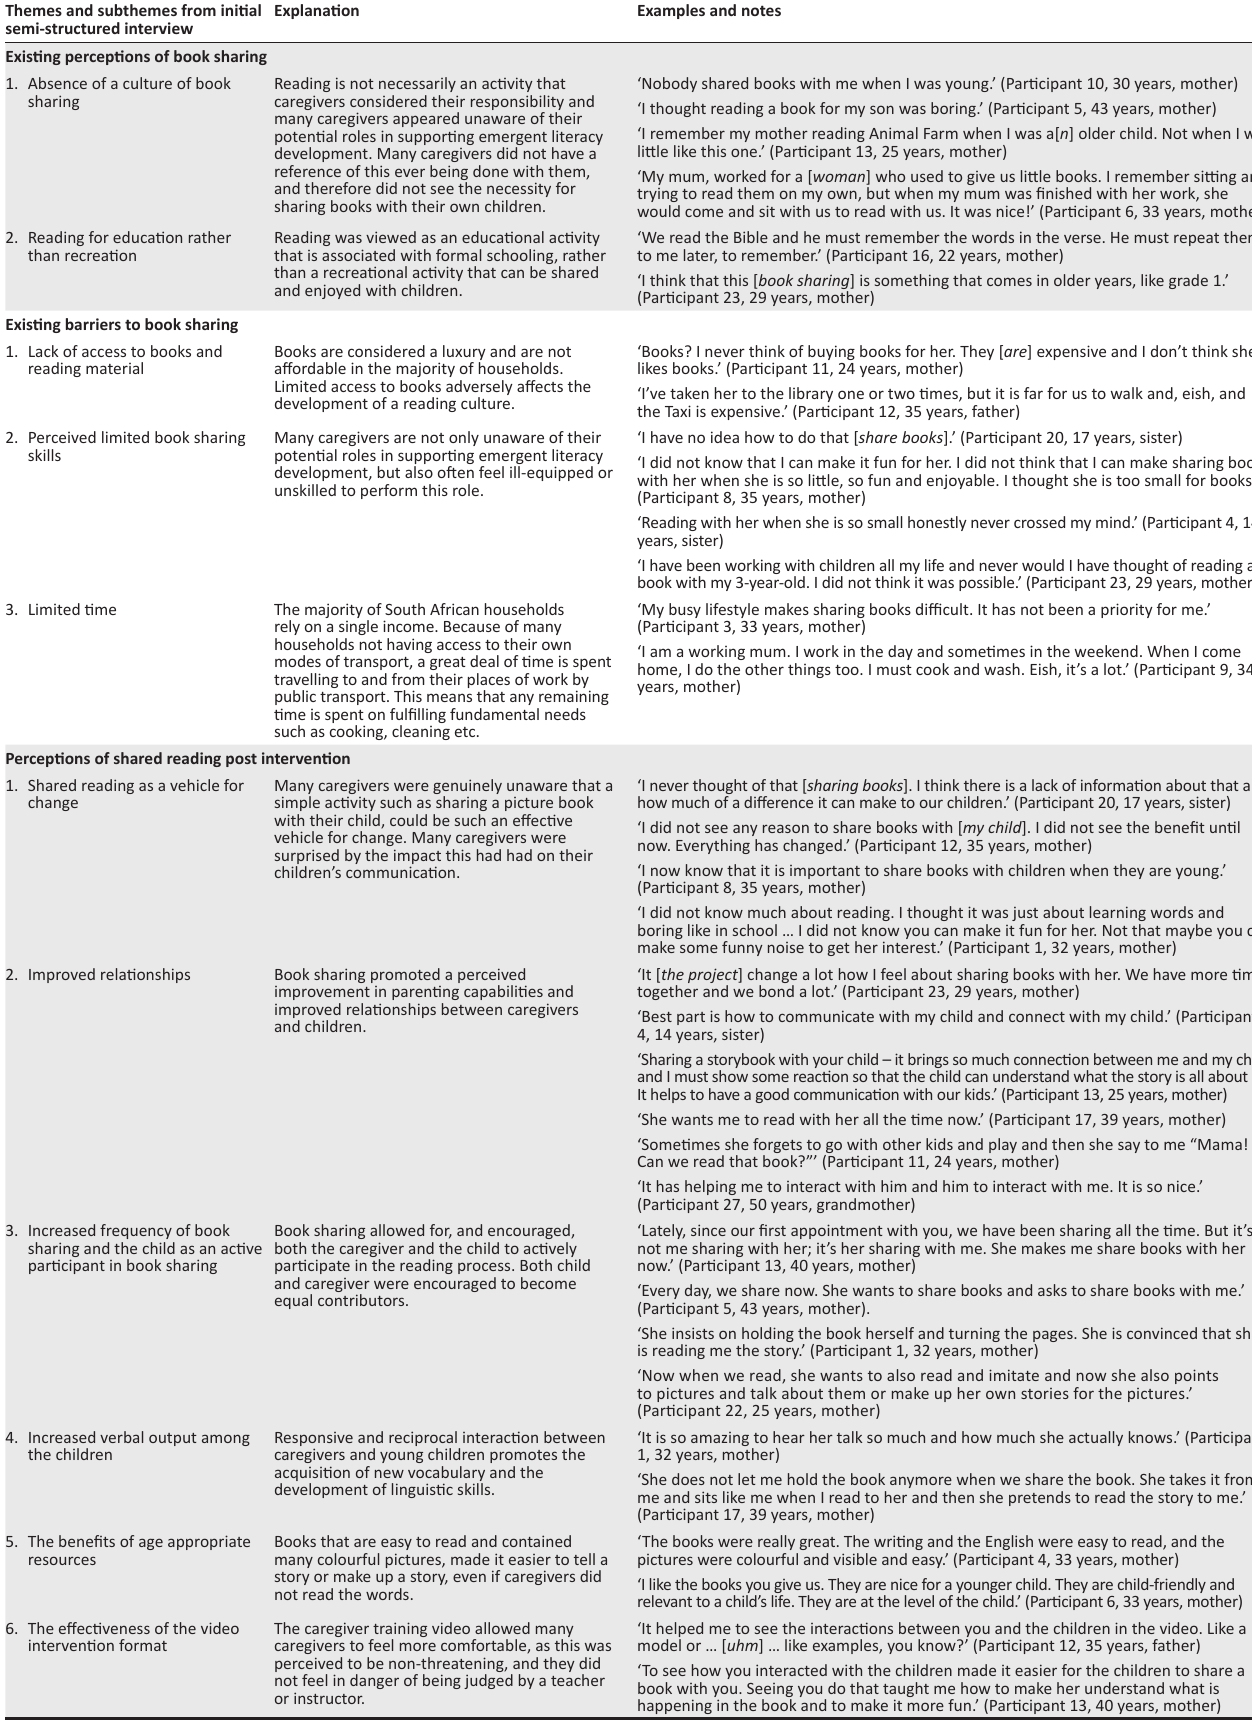
TABLE 2: Themes and subthemes, with verbatim examples from the